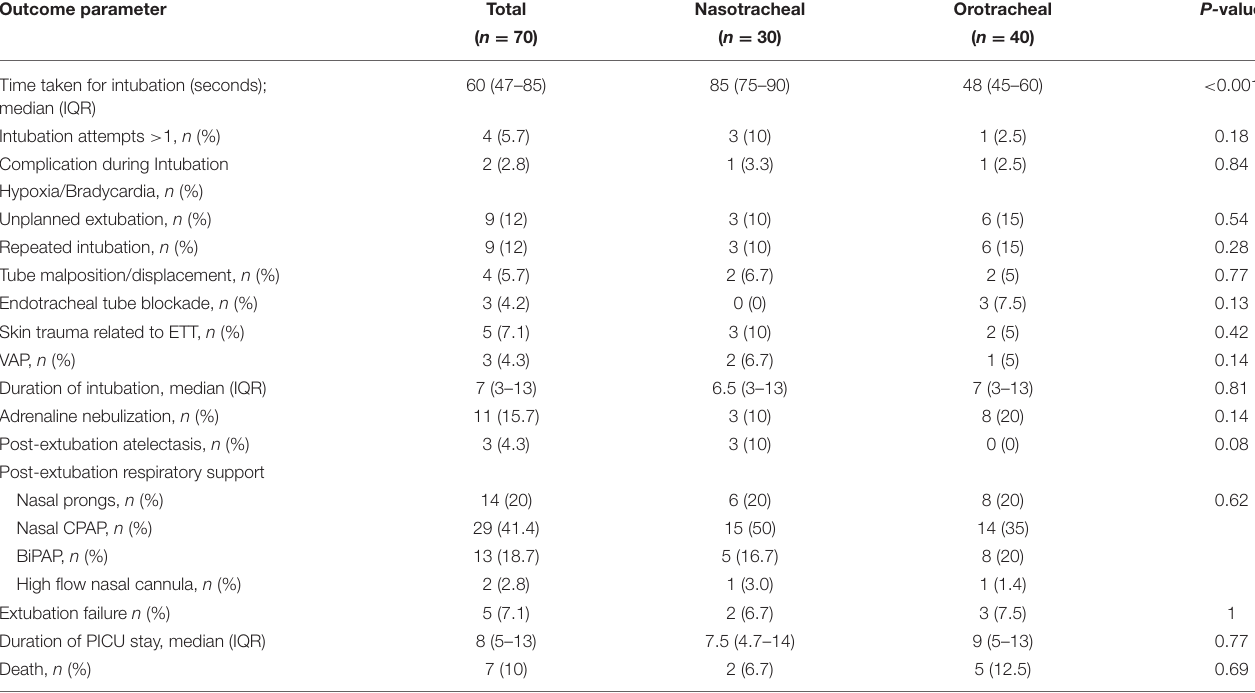
TABLE 3 | Secondary and final outcomes in nasotracheal and orotracheal intubation groups. Outcome parameter Total